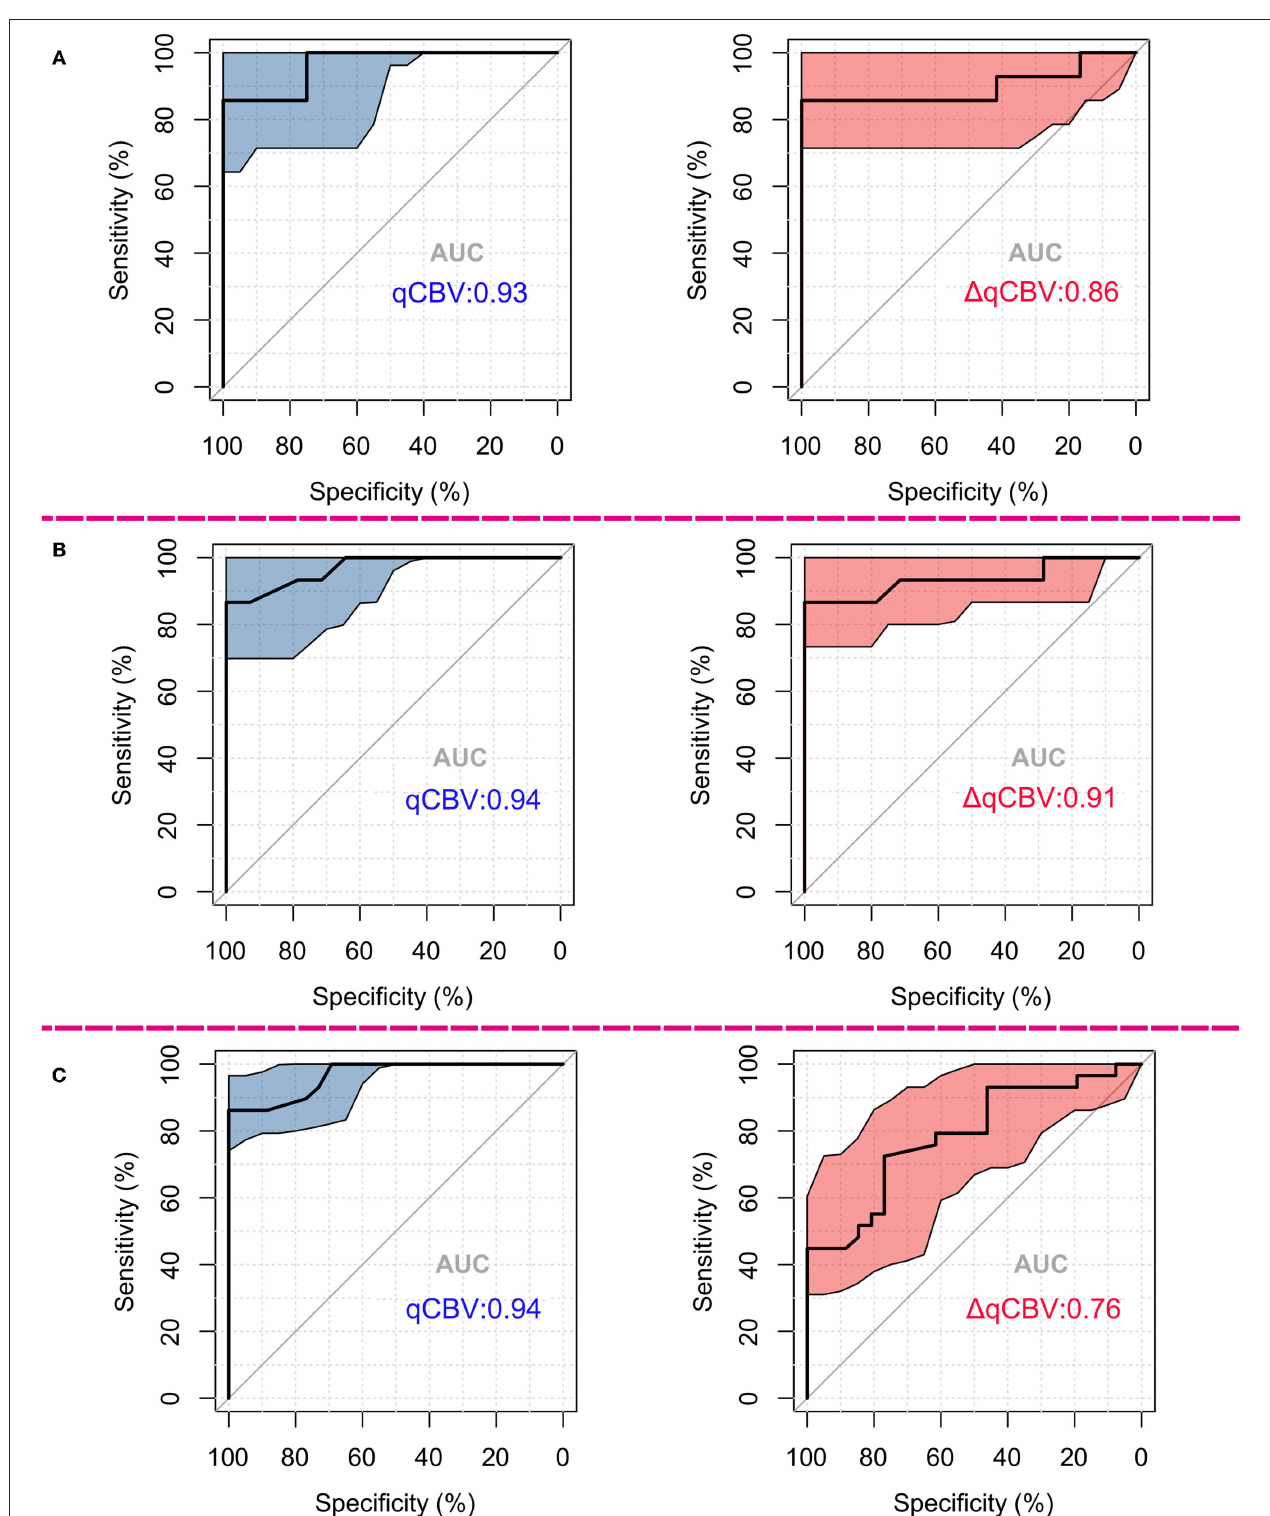
FIGURE 1 | ROCs differentiating radionecrosis from recurrence of BMs after GKRS treatment. (A) ROCs in hyperperfusion groups; (B) ROCs in hypoperfusion groups; (C) ROCs among all mixed patients. For (A–C) , the left subfigure shows the ROCs of qCBV, and the right subfigure shows those of 1 qCBV. The colored area in the map indicates the 95th percentile confidence interval of the AUC. ROC, receiver operating curve; GKRS, gamma knife radiosurgery; AUC, area under the ROC.